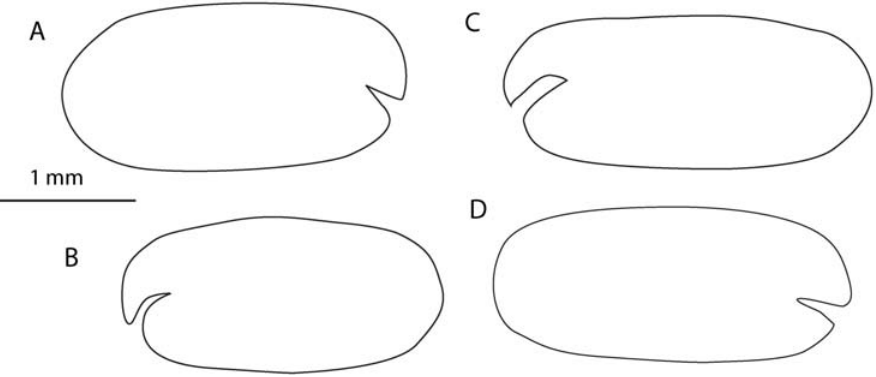
Figure 1. Cylindroleberismariae, specimen number BMNH:1945.9.26.101-104. A, carapace of holotype; B-D, carapaces of additional material from Shetland